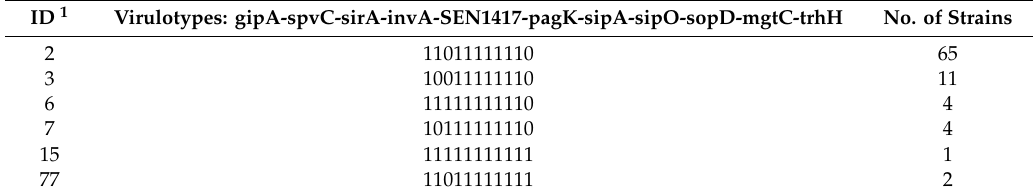
Table 3. Virulence gene combinations (virulotypes) and their frequency in the isolated strains.